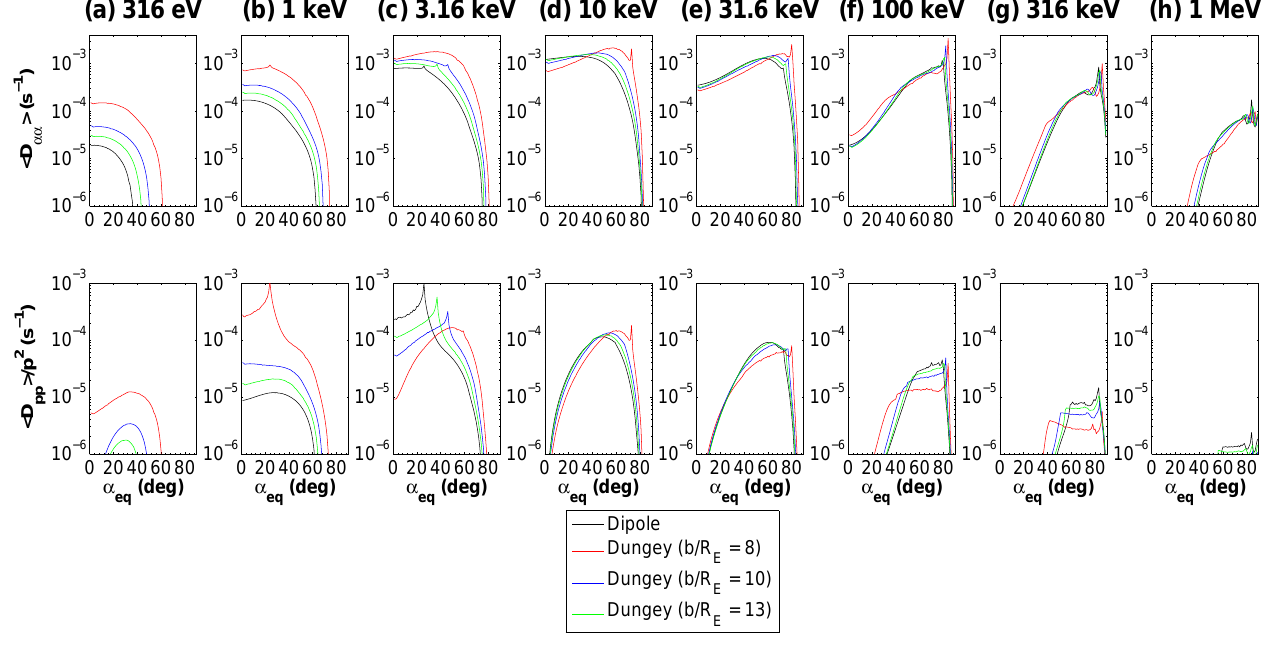
Fig. 5. h D αα i and (cid:10) D pp (cid:11) /p 2 as a function of equatorial pitch angle α eq in the four Dungey magnetic fields at r 0 = 6 R E for eight specific energies from 316eV to